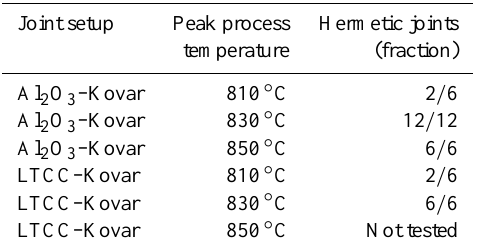
Figure 9. SEM image of a Kovar–LTCC joint brazed with Cusil- ABA at 810 ◦ C for